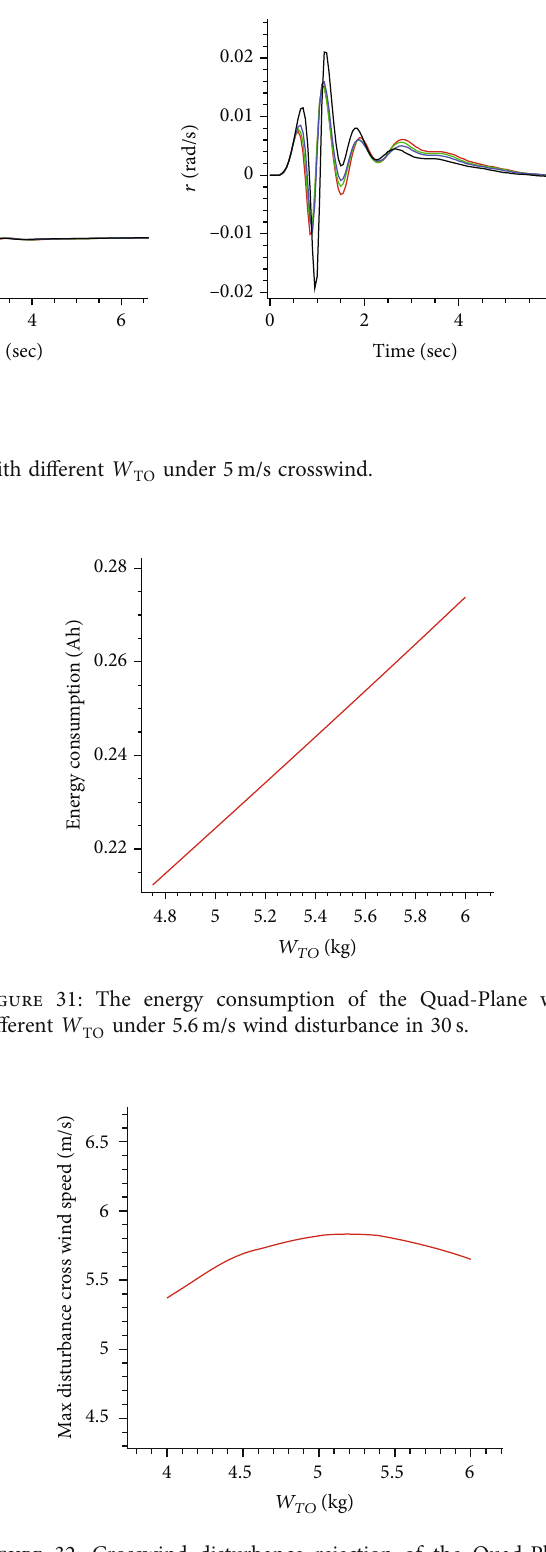
Figure 32: Crosswind disturbance rejection of the Quad-Plane performance with di ff erent W TO